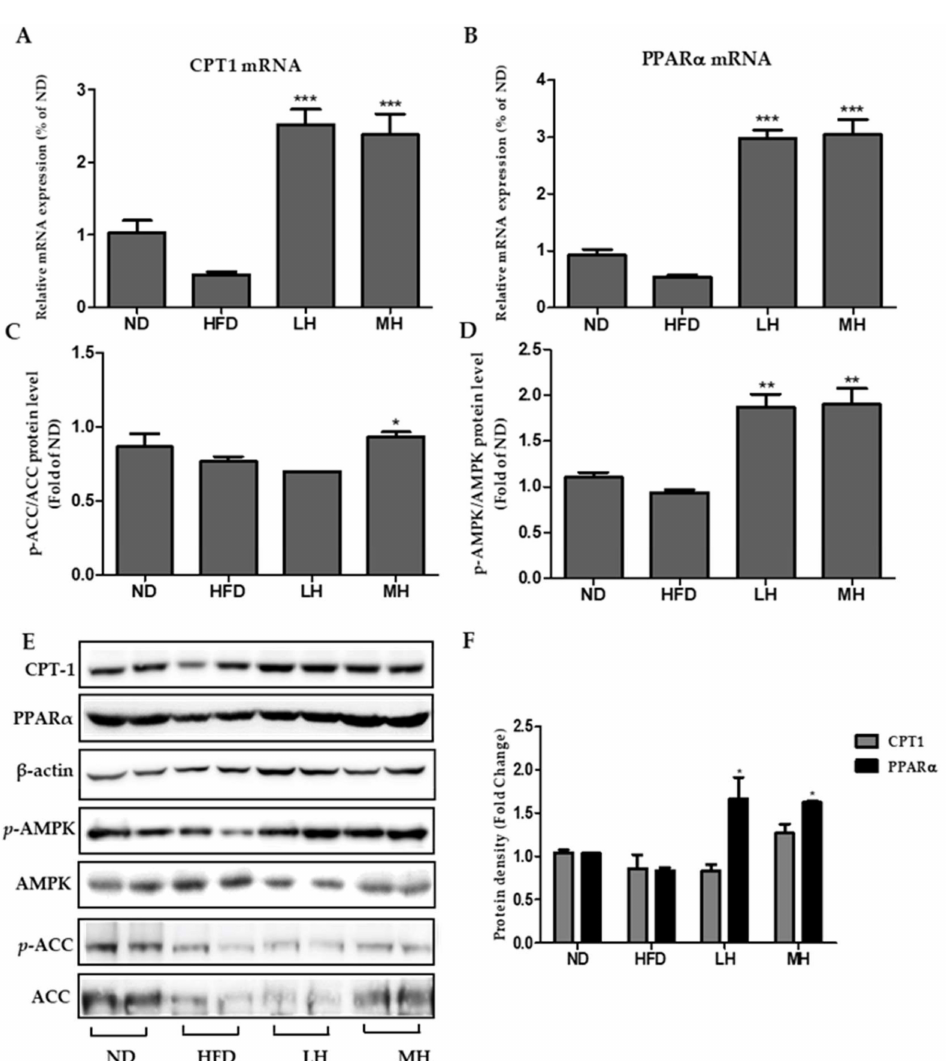
Figure 8. Effects of HBE on CPT-1 and PPAR α expression and AMPK, ACC signaling in HFD-fed mice. The expression of CPT-1 ( A ) and PPAR α ( B ) were quantified by real-time PCR and normalized by β -actin as an internal control. ( C – D ) Western blot analysis of p-AMPK/AMPK and p-ACC/ACC protein in the livers of mice fed an ND, HFD, or HFD with supplemented HBE (LH, 0.5% or MH,